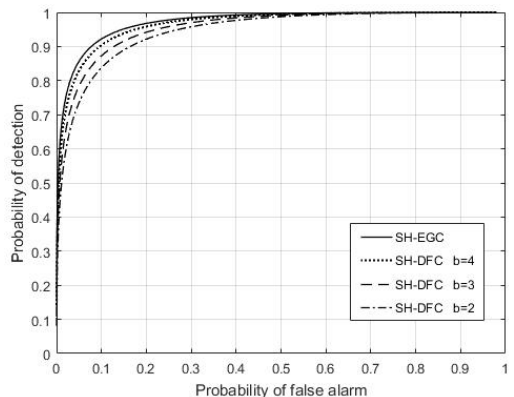
Figure 18. The probability of detection of two methods versus the global desired probability of false alarm at the FC.